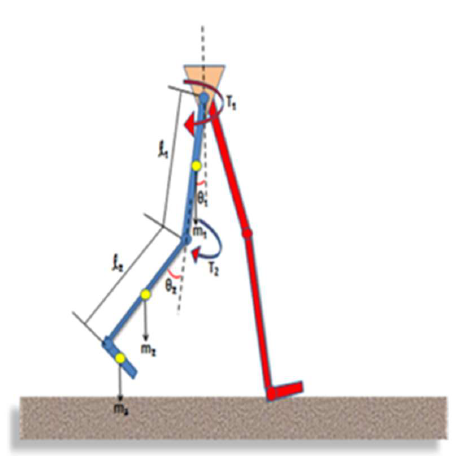
Fig. 5. Swing phase with hip joint extension and knee joint flexion .